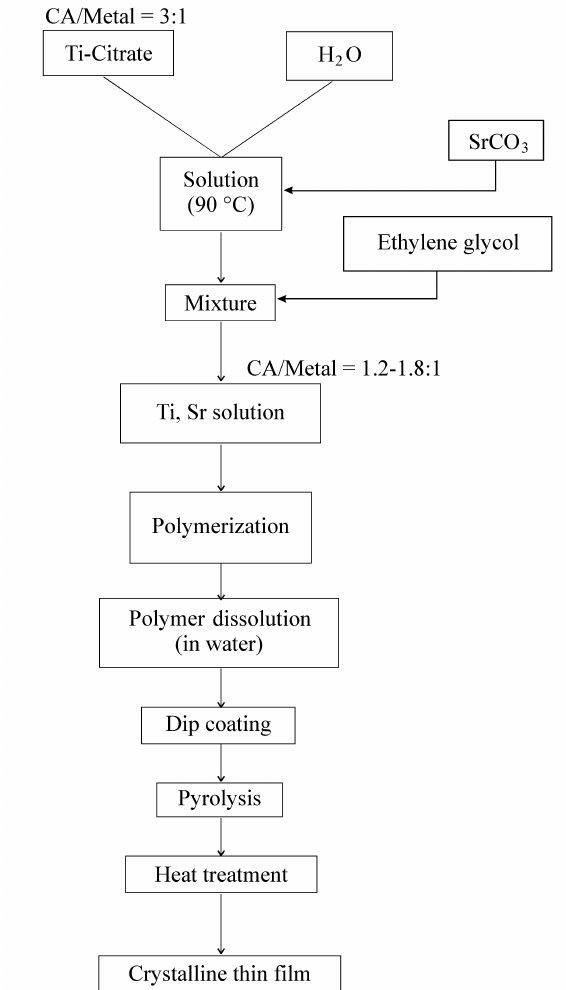
Figure 1. Flow chart for the preparation of SrTiO 3 thin film using the polymeric precursor